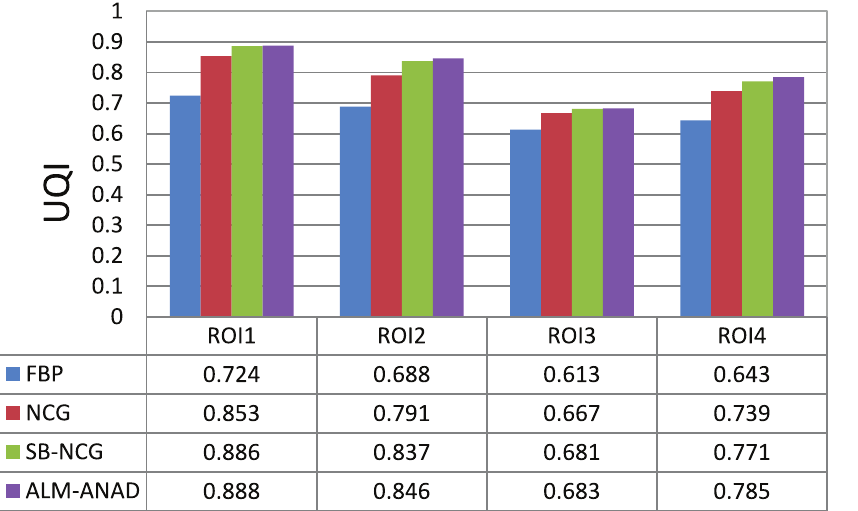
Fig 5. UQI measures on the four ROIs in Fig 5.